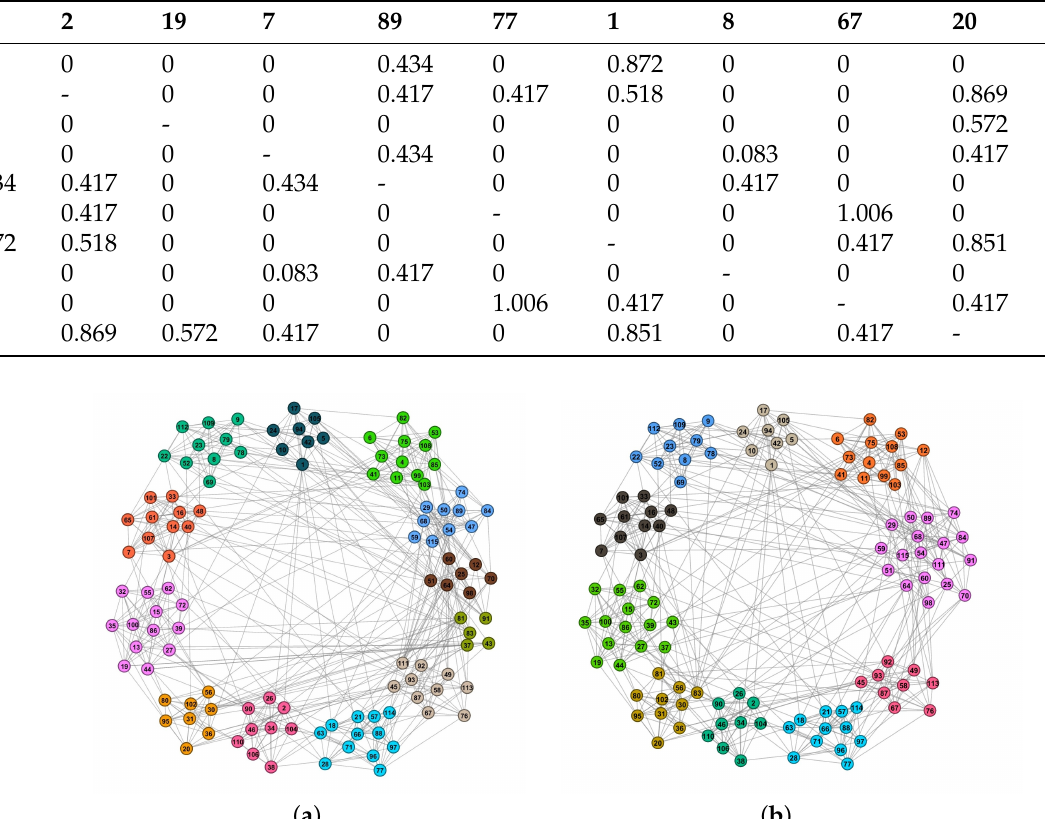
Figure 4. The community structure of Football network. ( a ) The real community structure. ( b ) The community structure detected by